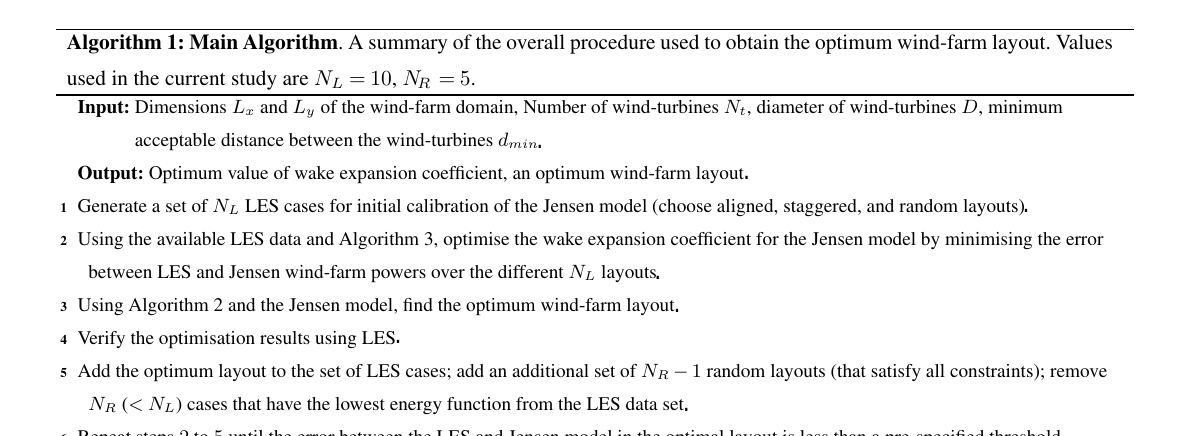
Fig. 2b: errors decrease fast at low values of T , but after- wards convergence stagnates. This is particularly problem- atic when looking at the turbine average power, which re- quires roughly 15 to 20/ u ∗ h to converge within 1 % of the reference average (requiring excessive computational costs – see below). It is further seen that the error on the over- all wind-farm power converges significantly faster, i.e. an error of 1 % is reached after approximately 5/ u ∗ h. This